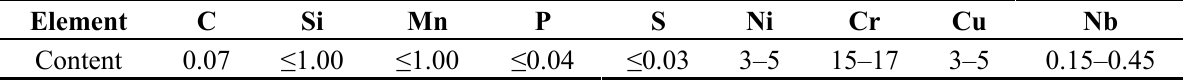
Table 1. The chemical composition of base metal